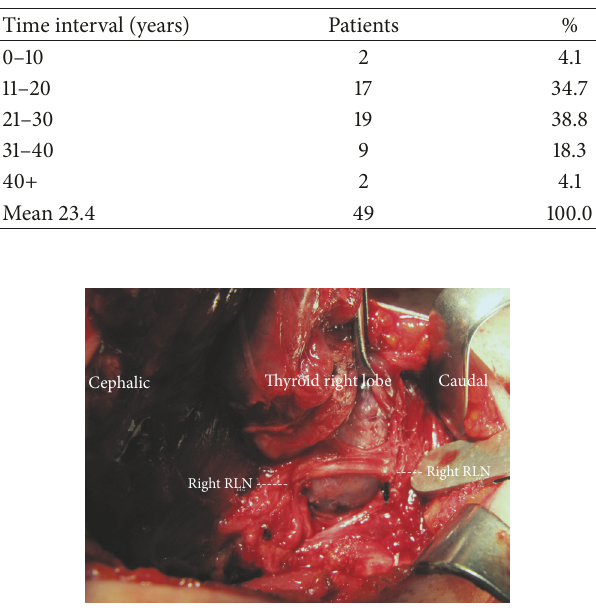
Table 2: Time interval between primary and redo surgery.